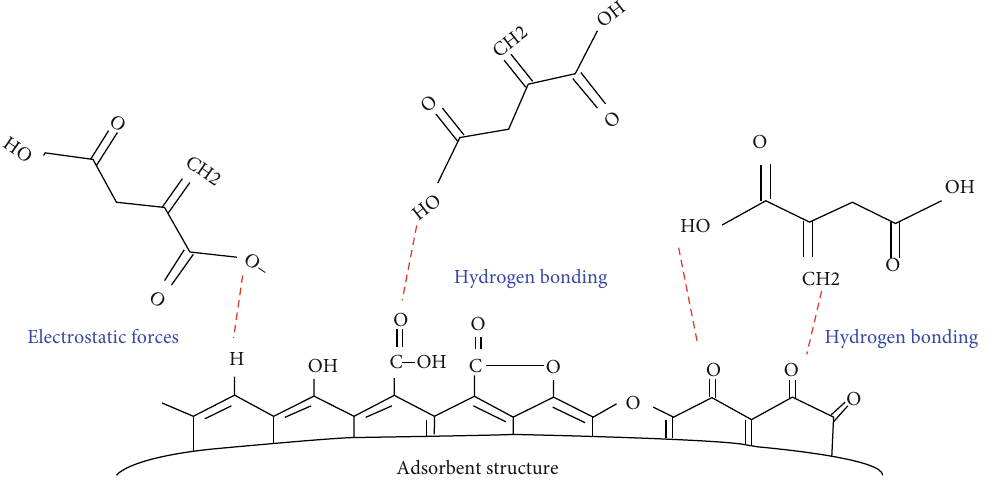
Figure 9: Possible adsorption mechanism for the separation of IA from aqueous solution using the best chosen coconut shell-based